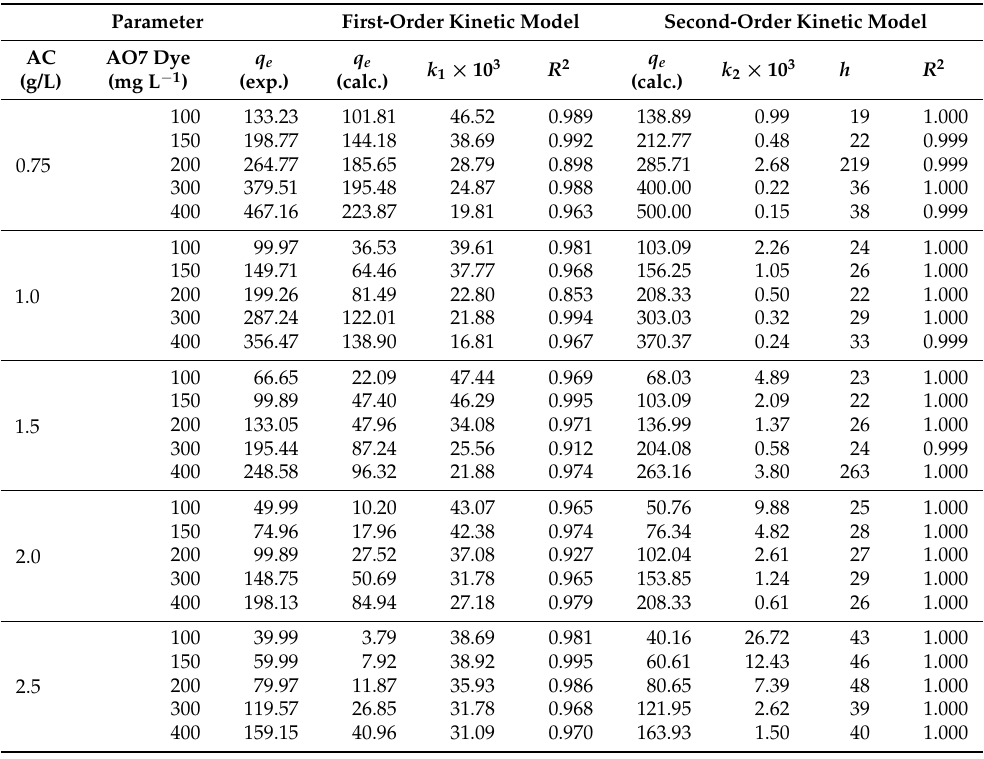
Table 3. The findings of pseudo-first-order and pseudo-second-order adsorption of AO7 dye at at a carbonization temperature of 800 degrees Celsius in the presence of CO 2 using ZnCl 2 as the activating